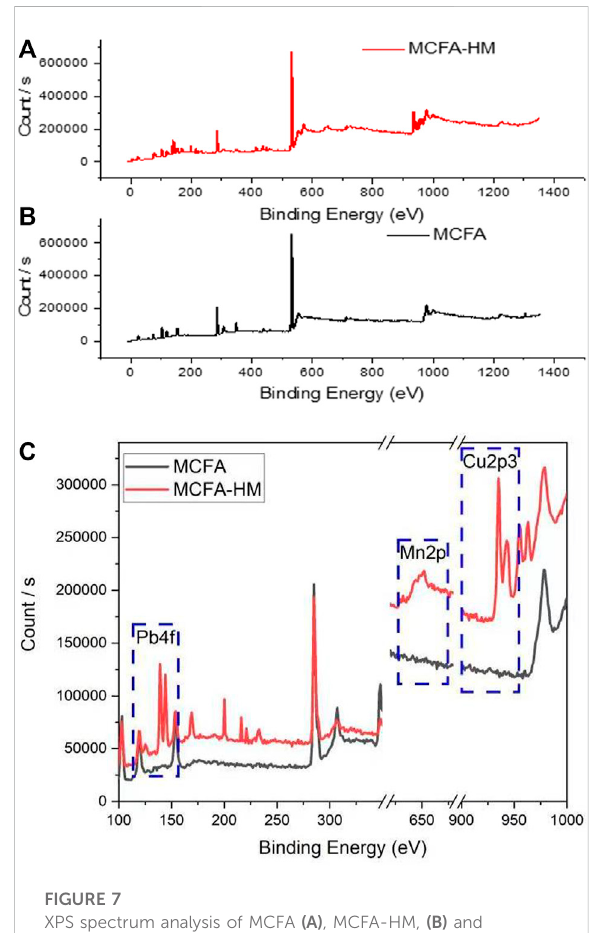
FIGURE 7 XPS spectrum analysis of MCFA (A) , MCFA-HM, (B) and comparison of MCFA and MCFA-HM (C)